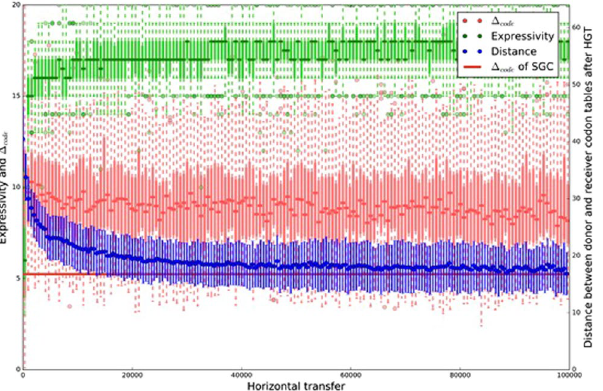
Figure 4. Emergence of artificial genetic codes. Results are averaged from 50 runs and plotted in intervals of 500 transfers. Expressivity counts the receiver’s encoded amino acids after a transfer (range [1, 20]), plotted as a box plot where the dark green bar represents the overall mean, the lighter green bar represents lower and upper quartiles, dotted lines represent minimum and maximum non-outliers, and circles represent outliers. Δ code represents optimality as the code’s robustness to single nucleotide changes (red box plot). The standard genetic code (SGC) has an expressivity of 20, the number of amino acids encoded in the code. The Δ code of SGC’s codons (excluding stop codons) is 5.24 (red line). The most robust artificial code with the same expressivity as the SGC has a